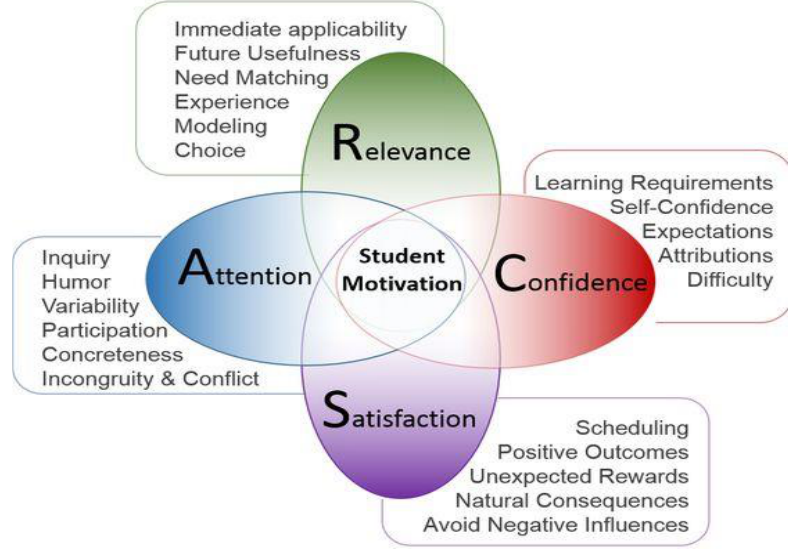
Figure 2: ARCS motivation model [8,